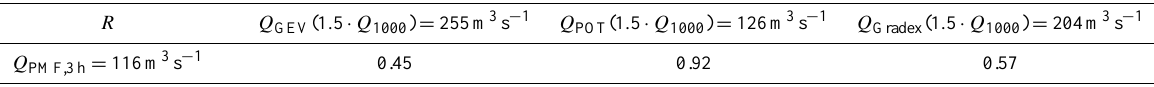
Table 1. Ratio R between the simulated discharges of Q PMF for 3h and the statistical estimations of the safety flood converted to hourly peak flow